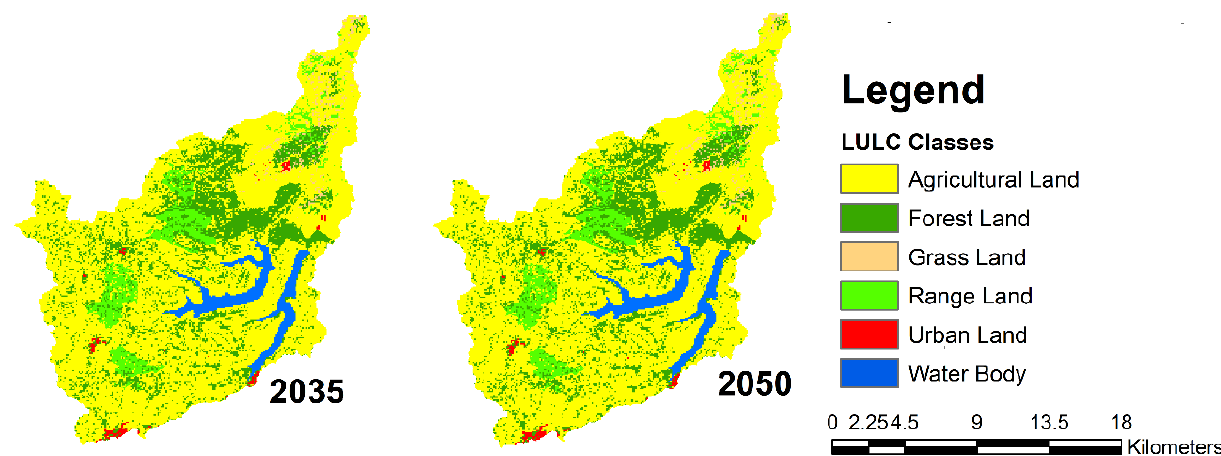
Figure 3. Predicted land use land cover of the Nashe watershed.